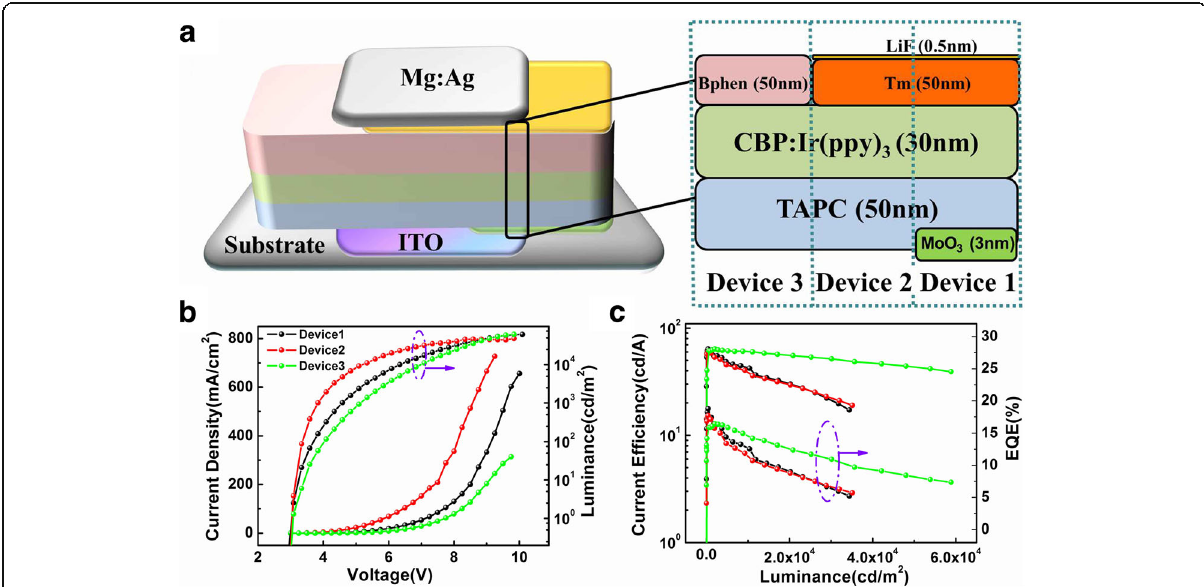
Fig. 3 a Structure diagram of the three devices. b Current density – voltage – luminance (J-V-L) curves. c Current efficiency – luminance – external quantum efficiency (CE-L-EQE)